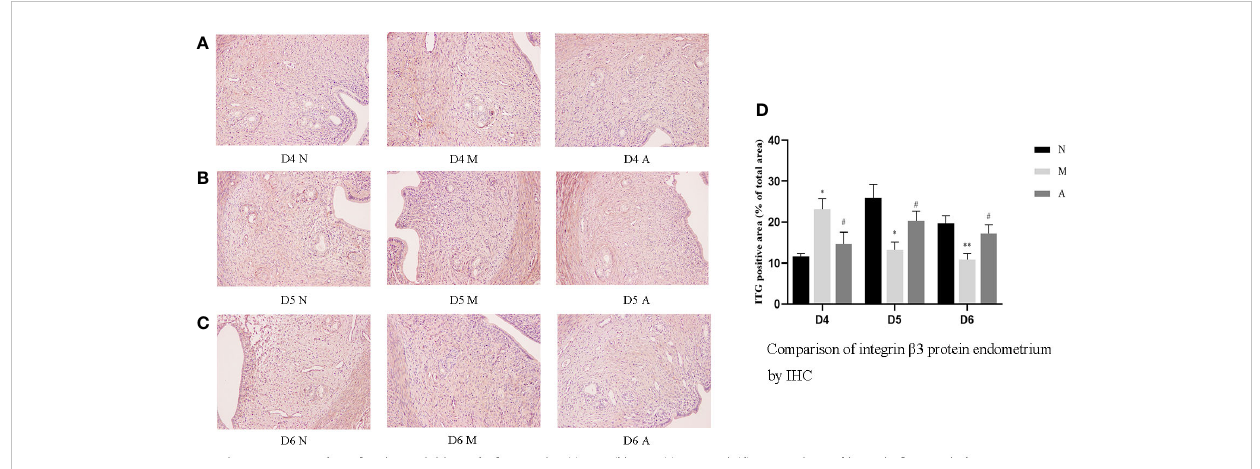
FIGURE 4 The expression of endometrial integrin b 3 protein: (A) D4; (B) D5; (C) D6; and (D) comparison of integrin b 3 protein by mean gray value (n=3). *or** represents that there is signi fi cant difference between M and N groups ( P < 0.05 or P < 0.01), #or ## represents that there is signi fi cant difference between A and M groups ( P < 0.05 or P < 0.01). Original magni fi cation *200. IHC, Immunohistochemistry; D, The embryo day; D4 N, D4 normal group; D4 M, D4 model group; D4 A, D4 acupuncture group; D5 N, D5 normal group; D5 M, D5 model group; D5 A, D5 acupuncture group; D6 N, D6 normal group; D6 M, D6 model group; D6 A, D6 acupuncture group; N, Normal group; M, Model group; A, Acupuncture group.